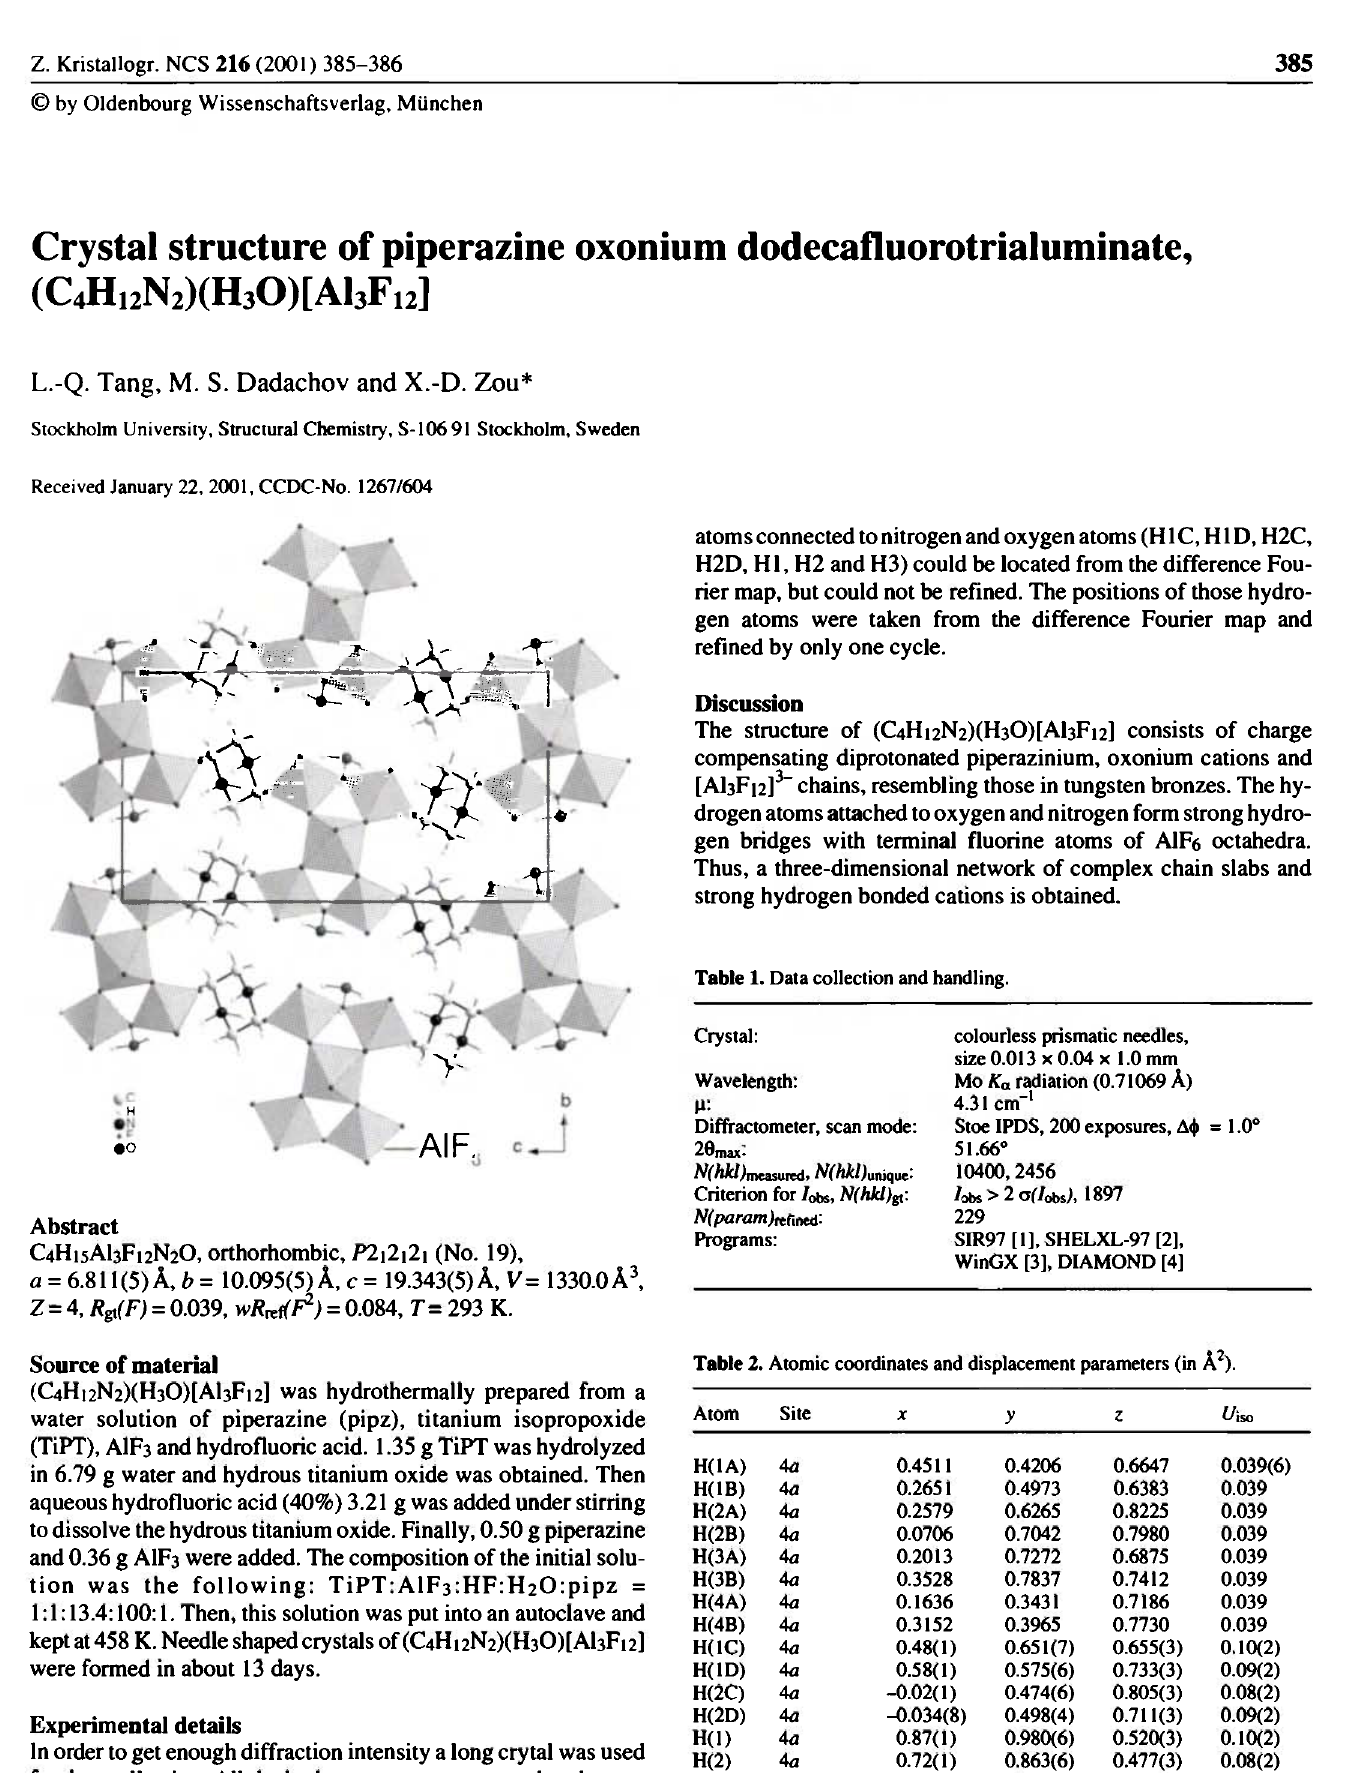
Table 2. Atomic coordinates and displacement parameters (in Ä 2